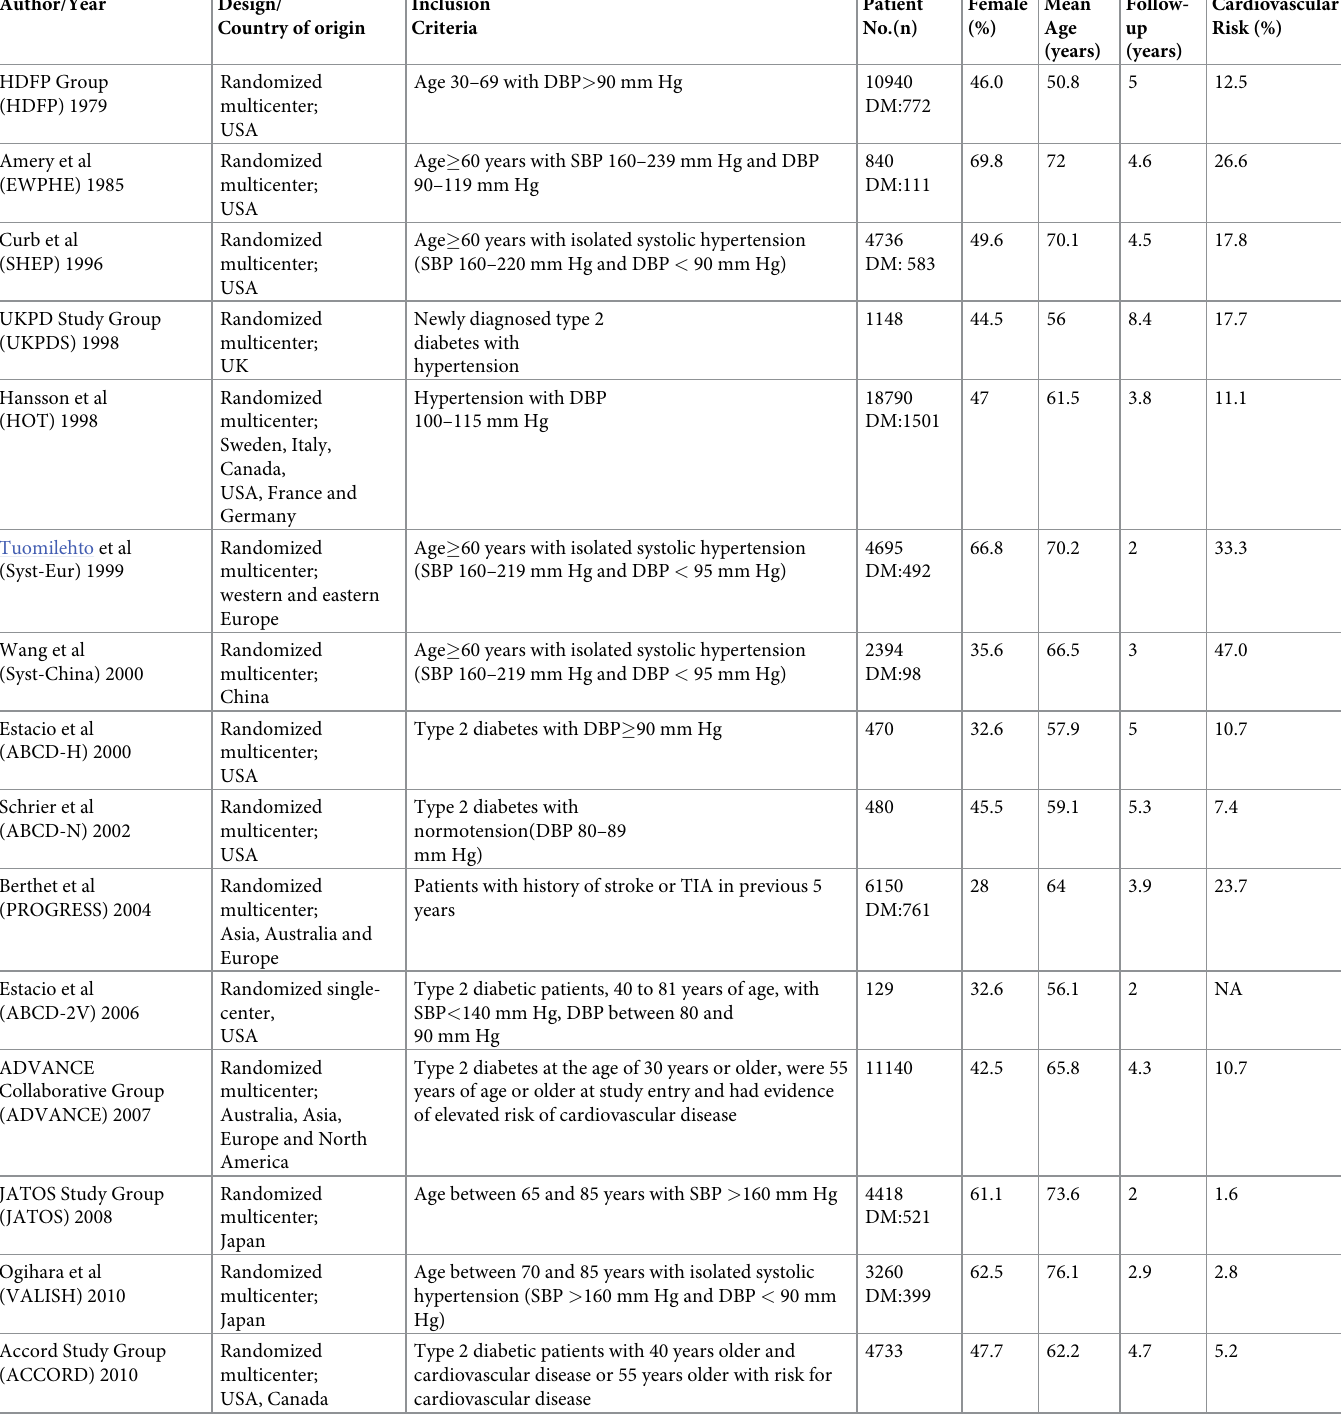
Table 1. Baseline clinical characteristics of trials included in the